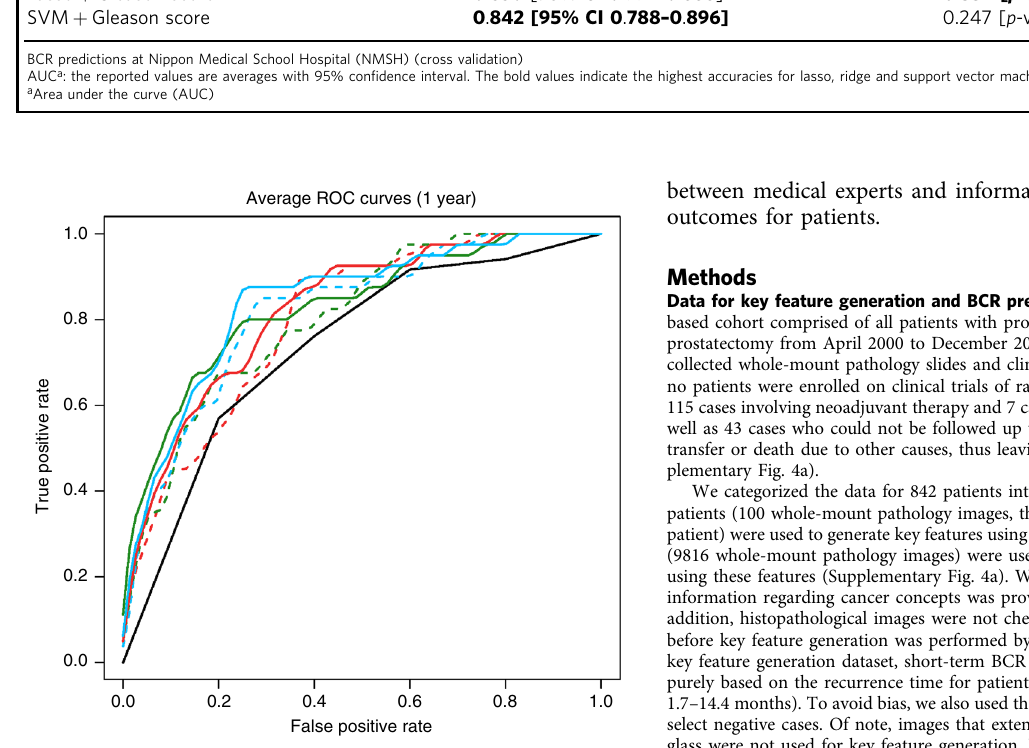
Fig. 3 Biochemical recurrence (BCR) prediction. Average receiver operating characteristic (ROC) curves for the BCR prediction within one year. Gleason score (black solid line), Ridge (red dot line), Lasso (green dot line), support vector machine (SVM; blue dot line), Ridge + Gleason score (red solid line), Lasso + Gleason score (green solid line), SVM + Gleason score (blue solid